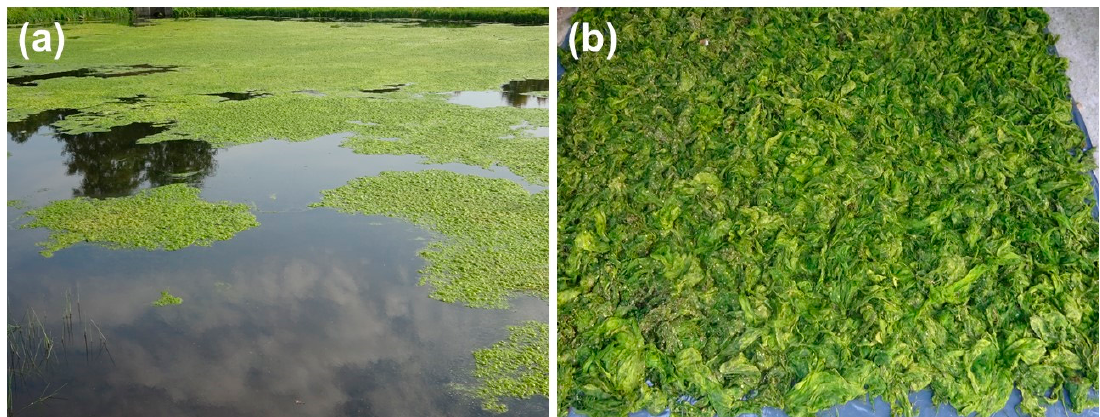
Figure 1. Cladophora glomerata on pond surface ( a ) and air-drying of freshwater macroalgae ( b ) (Photo: Izabela Michalak).